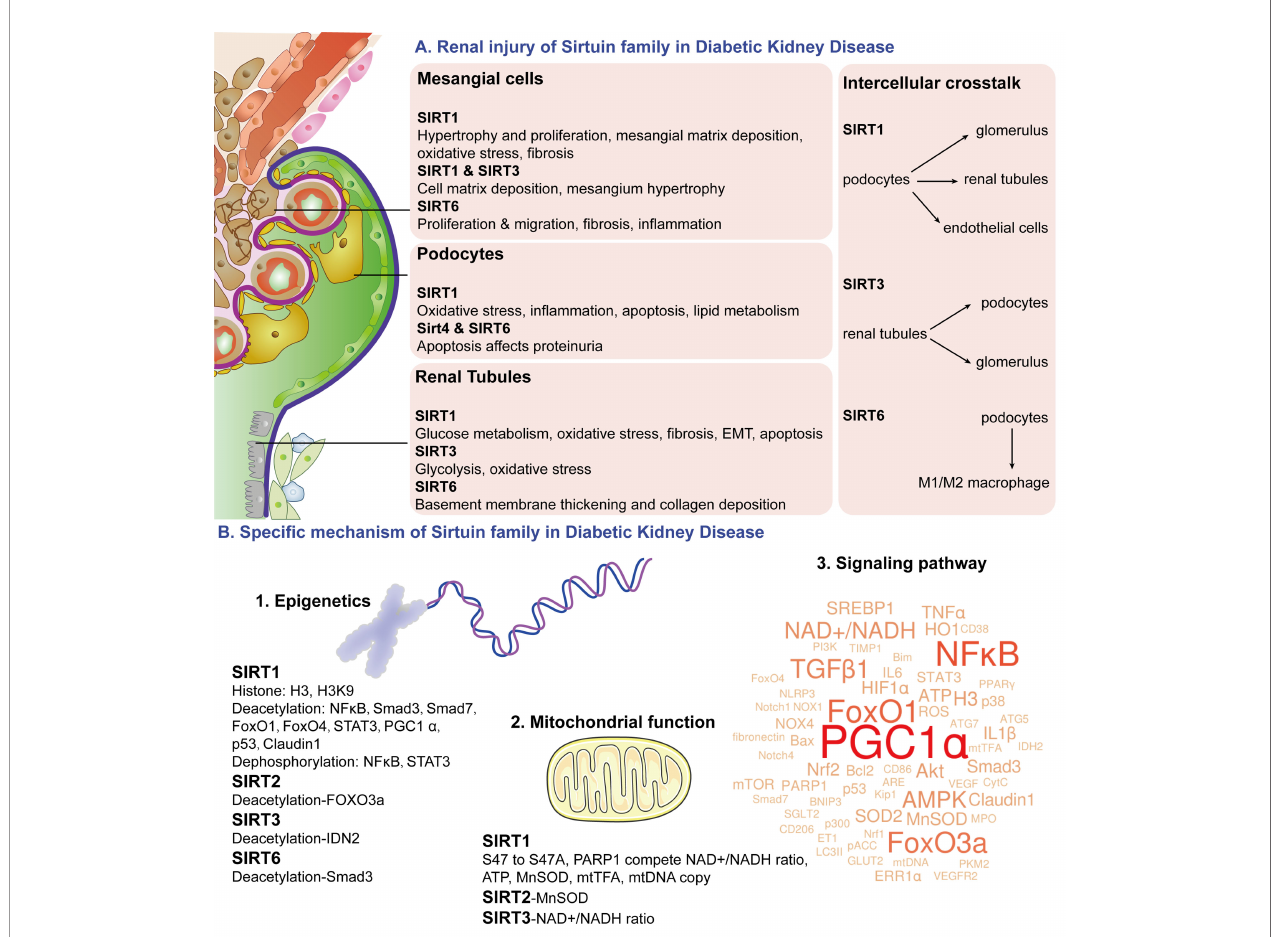
FIGURE 5 | Schematic diagram of Sirtuin family. The Sirtuin family is a deacetylase with an NAD + binding domain that consumes NAD + to regulate energy metabolism. Sirtuin family regulates mesangial cell proliferation and hypertrophy, podocytes apoptosis, glucose metabolism in proximal tubules, and renal tubular injury in DKD pathophysiological changes through epigenetics of acetylation and dephosphorylation, NAD + induced mitochondrial function, and multiple signaling pathway targets. It also participates in podocytes mediated renal tubular cells, endothelial cells, and macrophages crosstalk. (A) renal injury of Sirtuin family in DKD; (B) speci fi c mechanism of Sirtuin family in